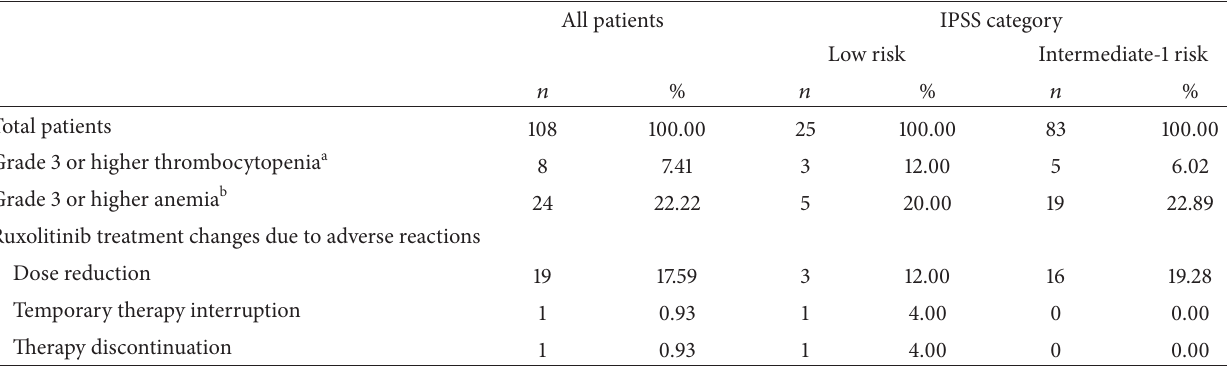
Table 3: Specific adverse events during ruxolitinib